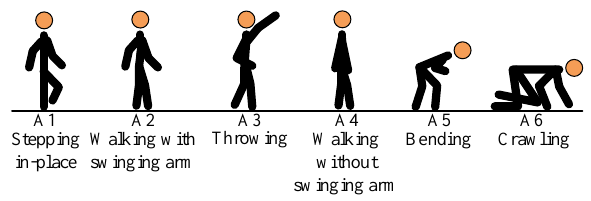
Figure 2. Six activity models in data